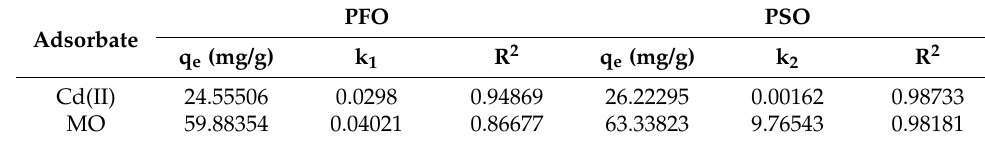
Table 4. Fitting parameters of adsorption kinetics by